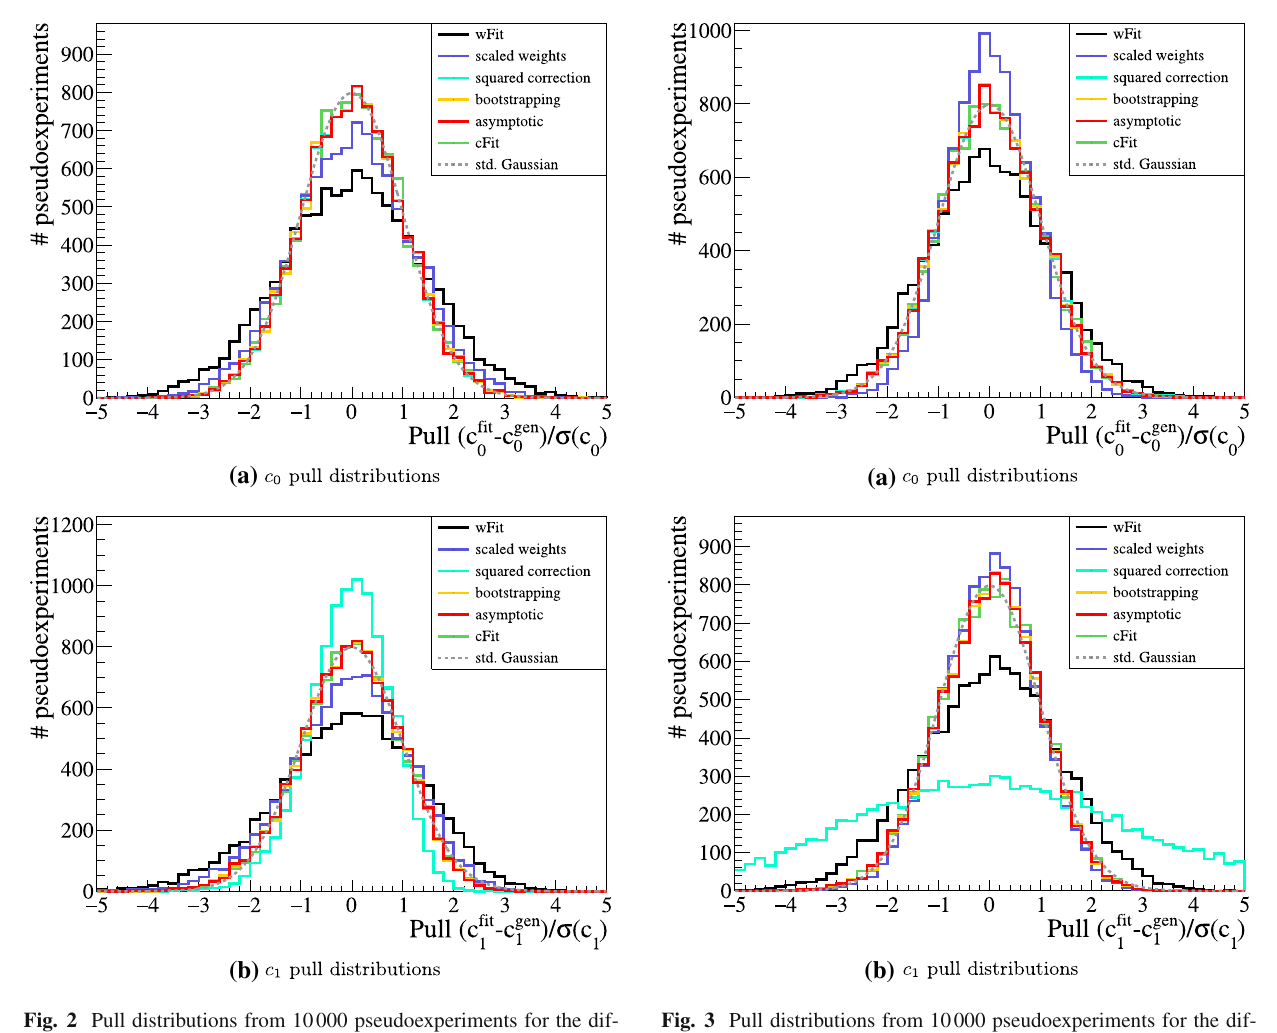
Fig. 2 Pull distributions from 10000 pseudoexperiments for the dif- ferent approaches to the uncertainty estimation for the efficiency cor- rection (cid:4)( cos θ) = 1 . 0 − 0 . 7cos 2 θ at a total yield of 2000 events for